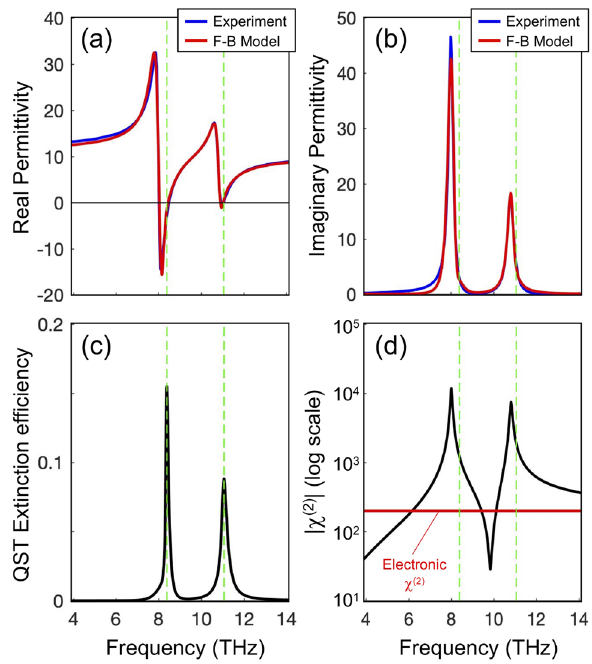
Figure 3. ( a , b ) Complex permittivity of AlGaAs in the THz region, showing the comparison between the experimental data (blue curve) and the F-B model (red curve) used in our simulation. ( c ) Linear extinction cross-section normalized to the pillar area estimated from quasi-static formulas. The resonance frequencies of the localized phonon-polaritons are marked by vertical green dashed lines. ( d ) Second-order susceptibility from ( 2 ) Eq. (1). The χ E electronic contribution is also shown in